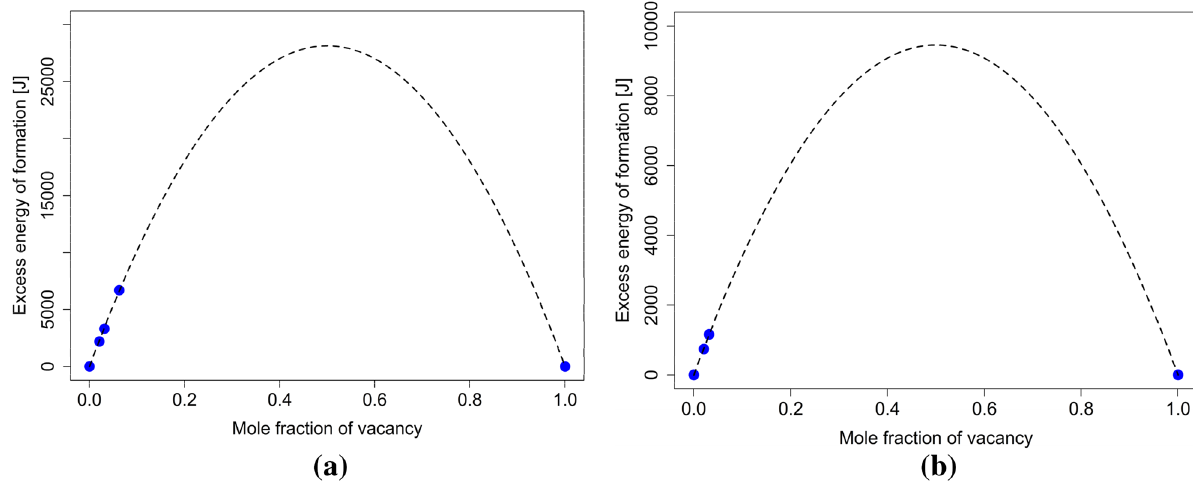
Figure 3. Excess energy of formation at 0 K per one mole of lattice sites ( a ) for FCC-Cu and ( b ) for